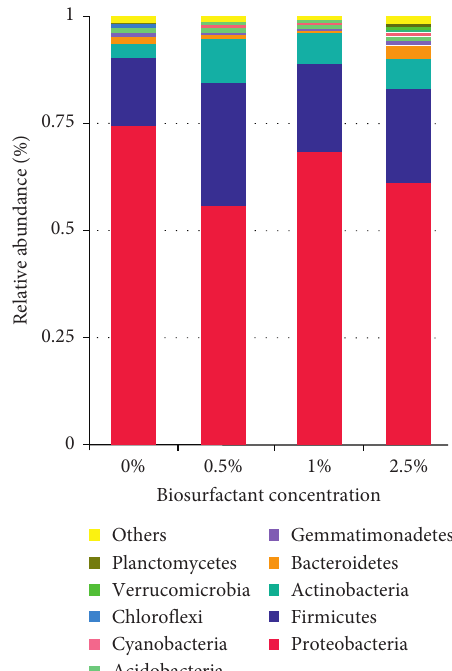
Figure 4: Relative abundances of the top ten bacterial phyla found in mortar samples with different biosurfactant